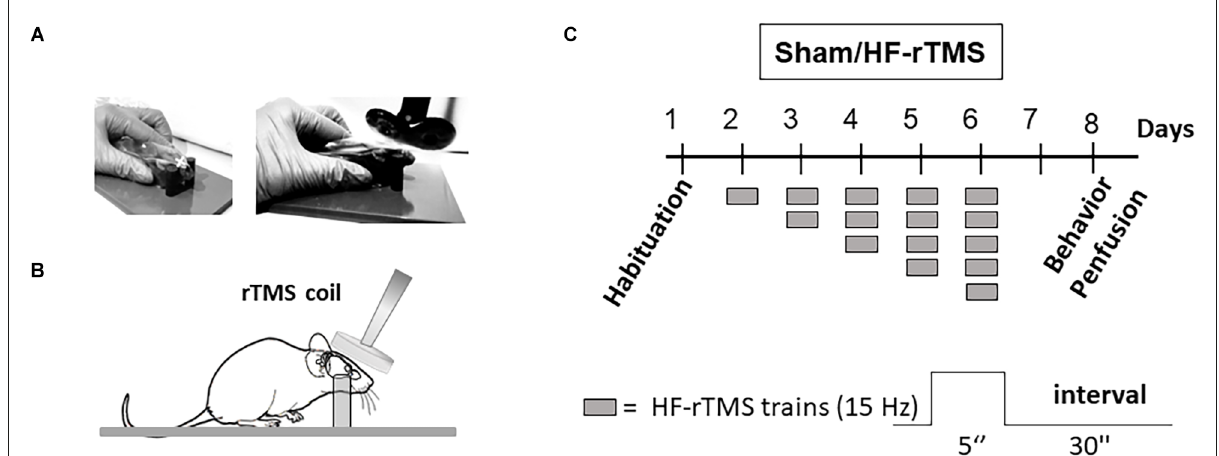
FIGURE1 High-frequency-rTMS (HF-rTMS) stimulation and experimental design. (A) Representative picture of the awake mice restrained by a soft plastic funnel and a (B) graphic representation of the stimulation setup. (C) Schematic of the experimental timeline and HF-rTMS stimulation protocol. Awake mice restrained with a soft plastic funnel were stimulated with a rodent figure-eight coil. Golgi-stained slices were used to analyze dendritic spine density and complexity of layer II/III and V in the mPFC, prelimbic